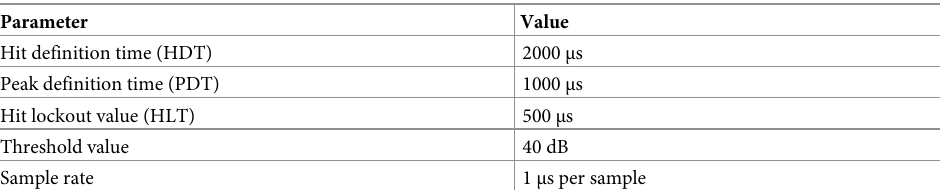
Table 1. AE parameters.